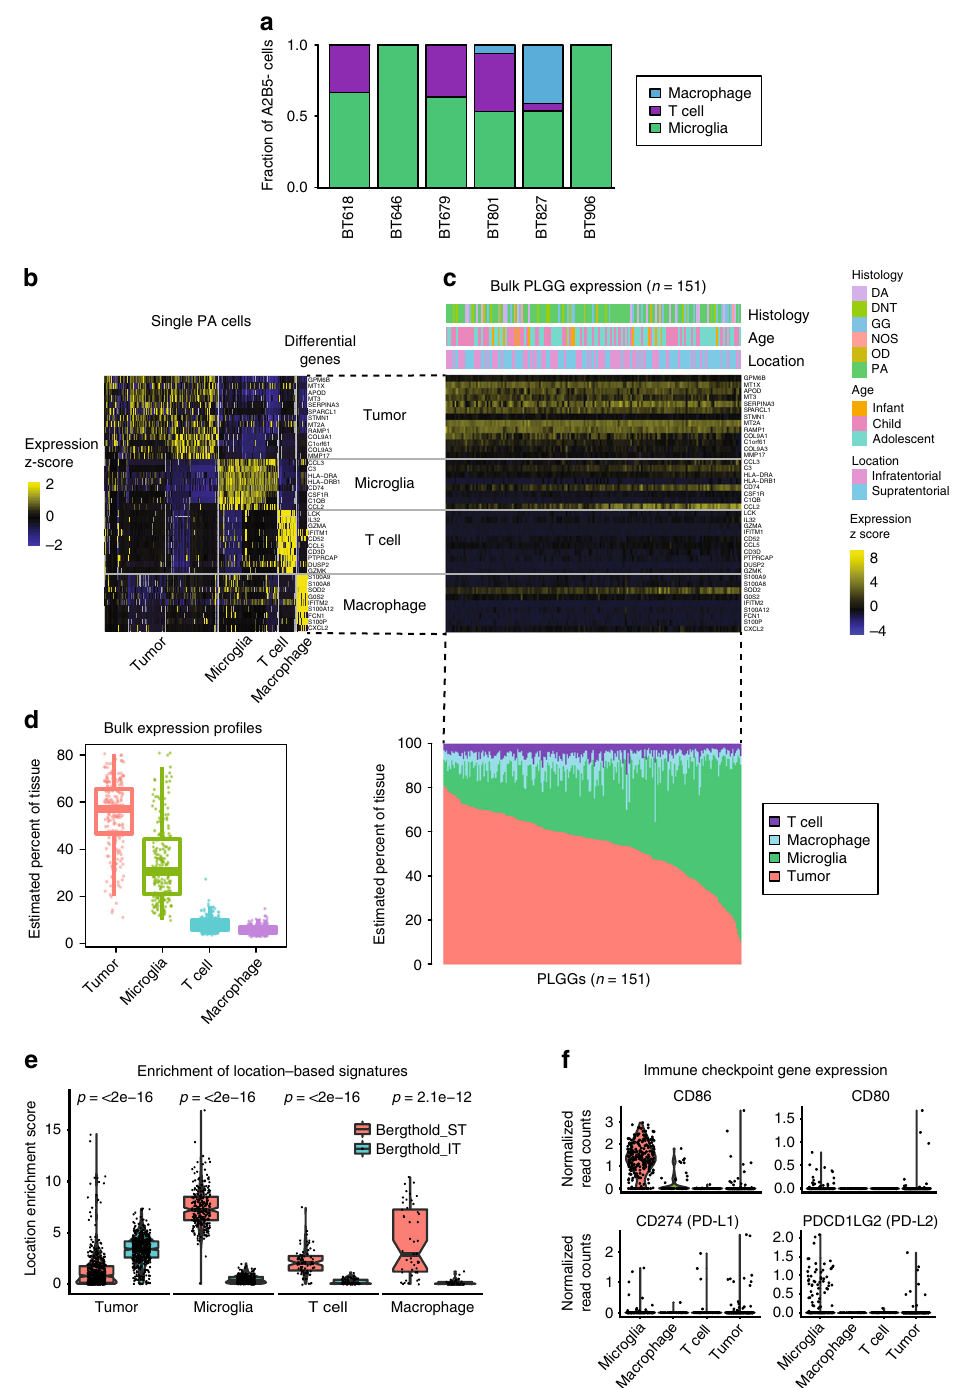
Fig. 3 Single cell RNA-seq analysis of immune cells in PA. a Fraction of microglia, macrophages, and T cells identi fi ed among A2B5 − cells in six tumors subjected to scRNA-seq. b Heat map showing top differentially expressed genes (rows) for PA immune cell and cancer cell clusters. Cells ( n = 931, columns) are arranged by cancer cell and immune cell clusters. c Expression of the differential genes from panel b in bulk expression pro fi les of 151 pediatric low grade gliomas 19 (PLGGs). Histological subtypes are designated as: DA diffuse astrocytoma, DNT dysembryoplastic neuroepithelial tumor, GG ganglioglioma, OD oligodendroglioma, NOS not otherwise speci fi ed. d Estimated proportion of tumor and immune cells in 151 pediatric low grade gliomas 19 , based on relative expression of gene signatures for tumor and immune cell types derived from single cell RNA-seq analysis. Center line shows median, hinges show 1st through 3rd quartiles, and whiskers extend to 1.5 times the interquartile range or the value fathest from hinge, whichever is less. e Enrichment of gene signatures derived from comparison between bulk expression pro fi les of supratentorial and with infratentorial tumors 19 , among cell types in the single-cell dataset. P -values are for Wilcoxon rank sum test. f Expression of immune checkpoint ligand genes CD86, CD80, CD274 encoding PD-L1, and PDCD1LG2 encoding PD-L2 in tumor and immune compartments of six PA tumors analyzed with scRNA-seq. Center line shows median, hinges show 1st through 3rd quartiles, and whiskers extend to minimum and maximum data